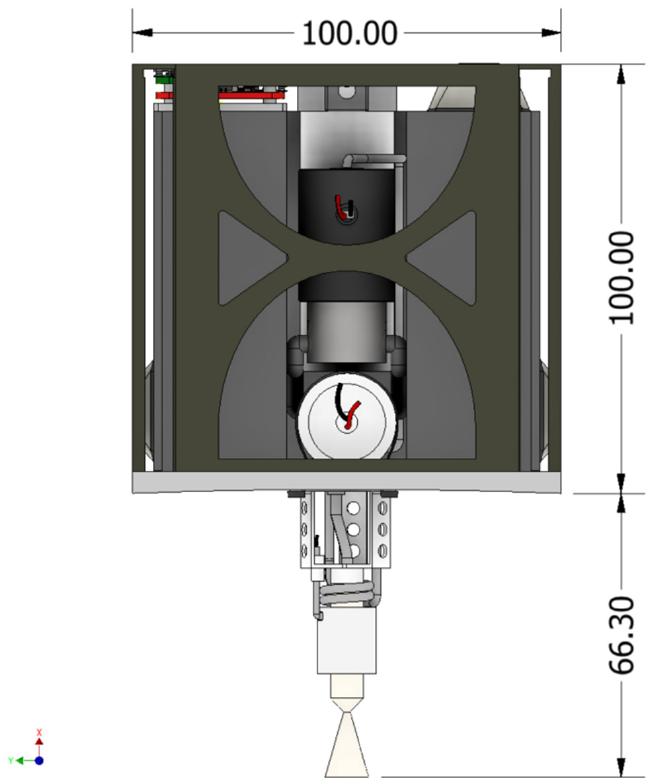
Figure A1. MIMPS-G500mN envelope dimensions (mm).